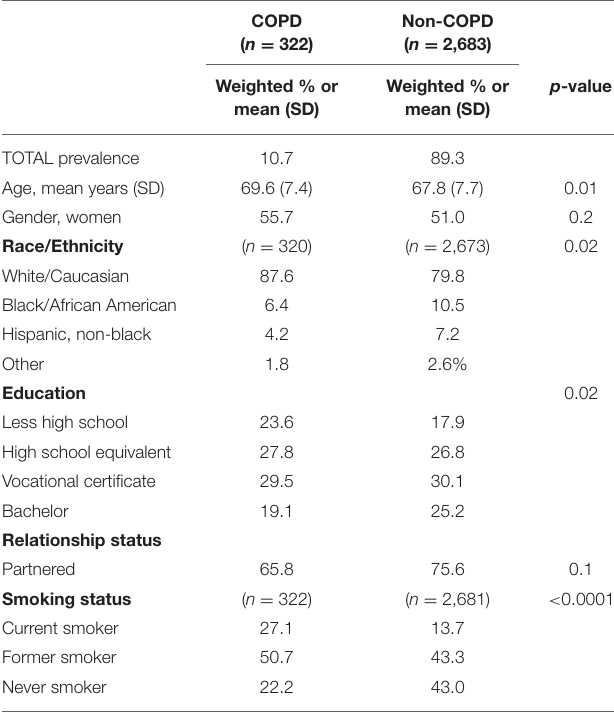
TABLE 1 | Demographic characteristics of US older adults with and without COPD by self-report.